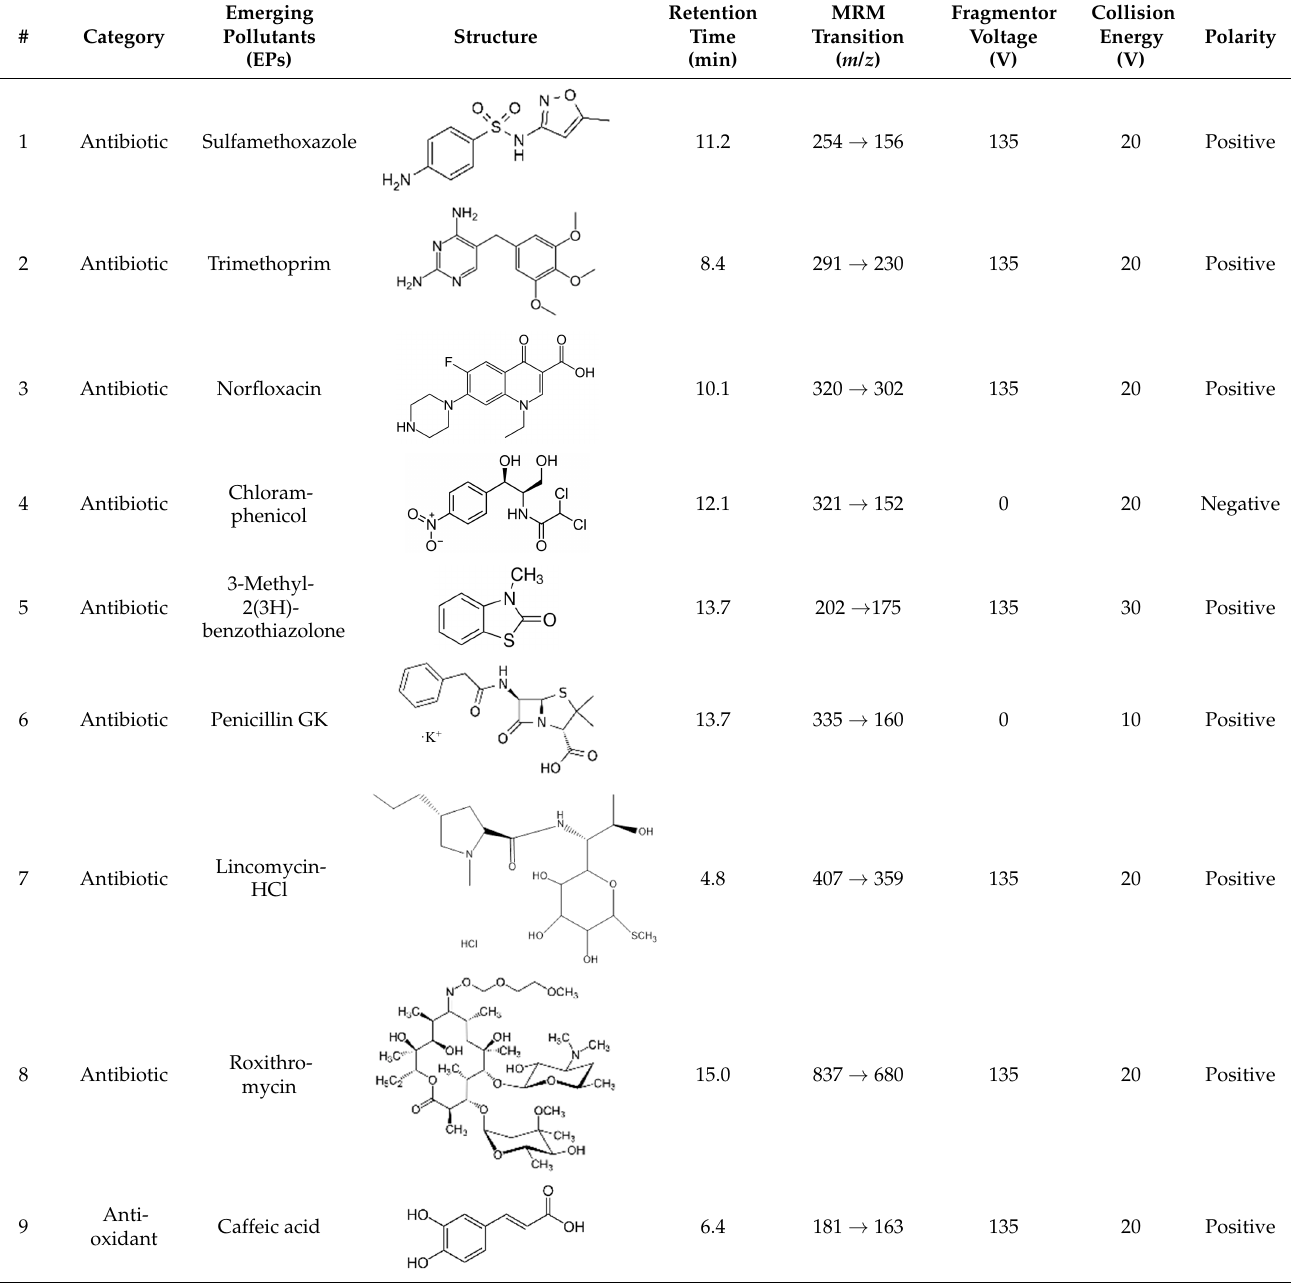
Table 1. Summary of the chemical structures as well as the LCMSMS parameters for the EPs used in the current study.